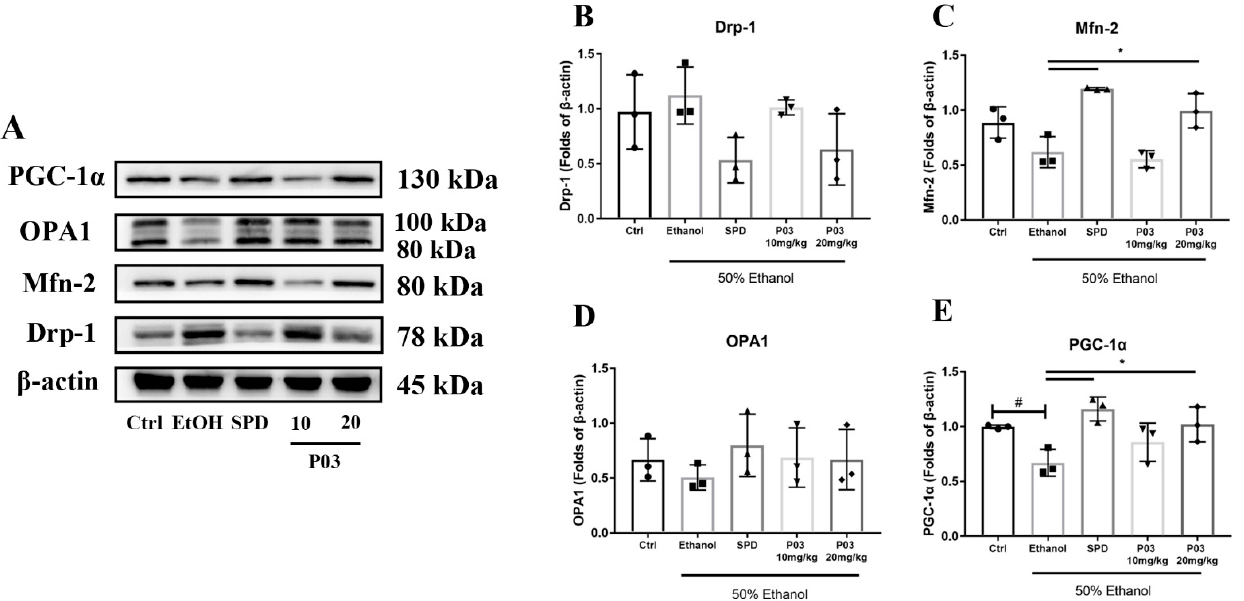
Figure 9. Immunoblots of PGC-1 α , OPA-1, Mfn-2, and Drp-1. ( A ) Immunoblots of indicated pro- teins. ( B – E ) Densitometric quantification of PGC-1 α , OPA-1, Mfn-2, and Drp-1 were performed and normalized to β -actin levels. The values are represented as mean ± SD and plotted as fold-change. (Compared to Ctrl, # p < 0.05. Compared to ethanol, * p < 0.05) ( n = 3).